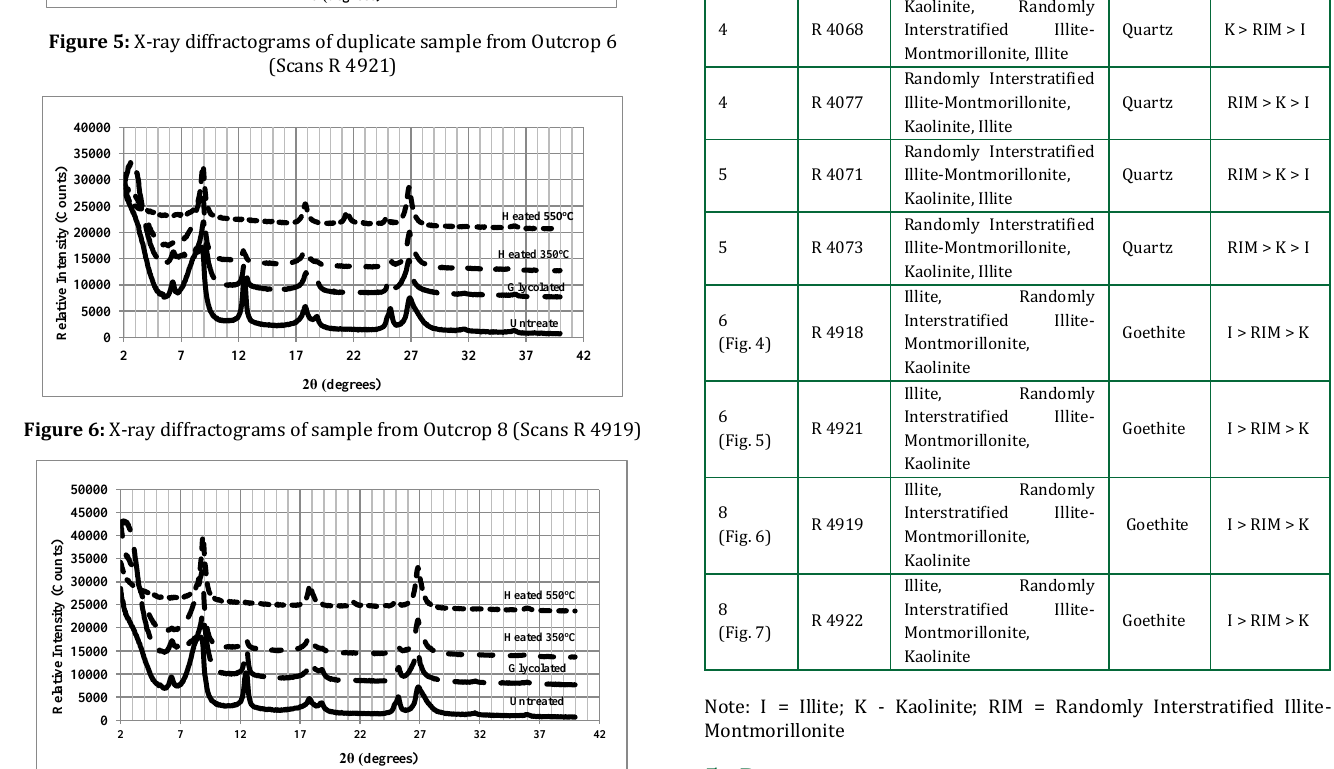
Figure 7: X-ray diffractograms of duplicate sample from Outcrop 8 (R 4922)